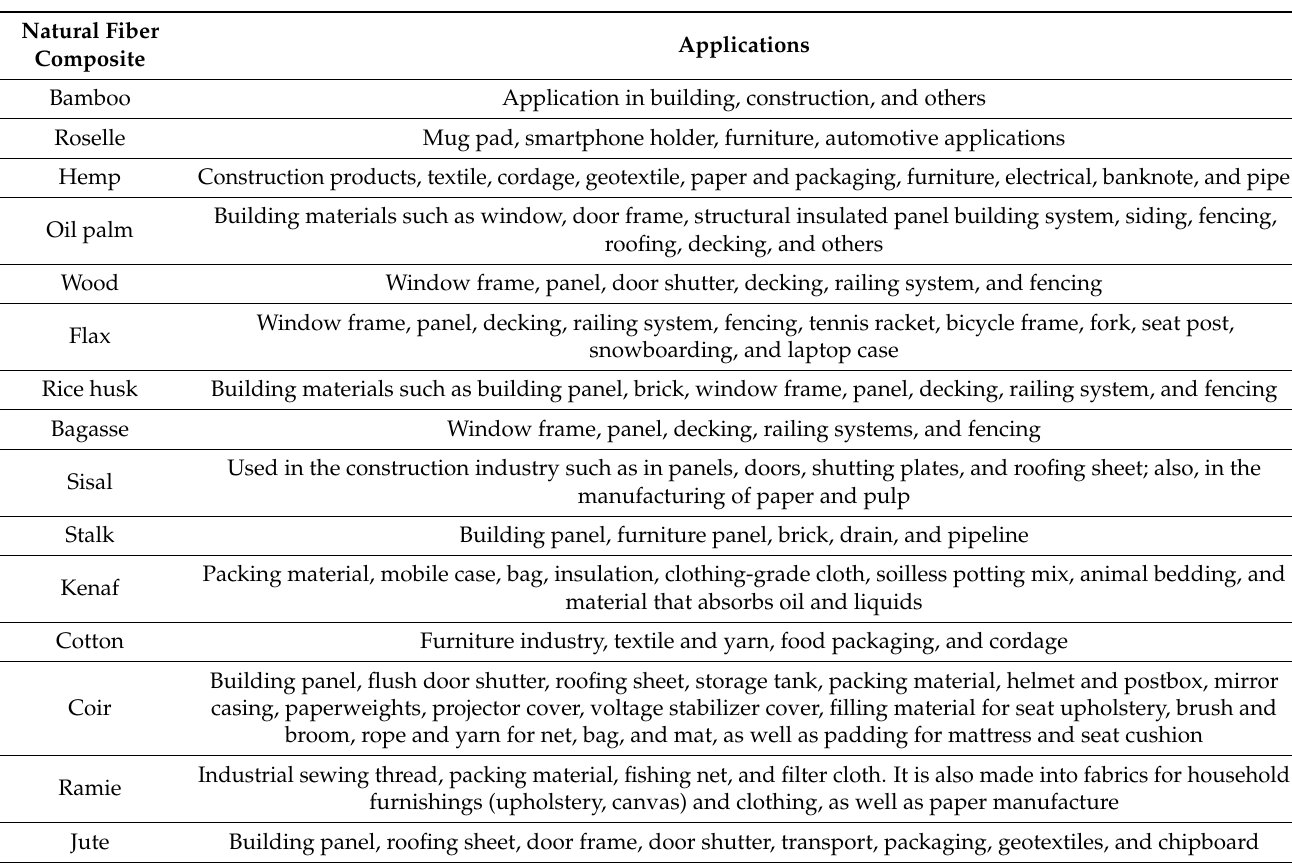
Table 7. Applications of natural fibers composites [143].